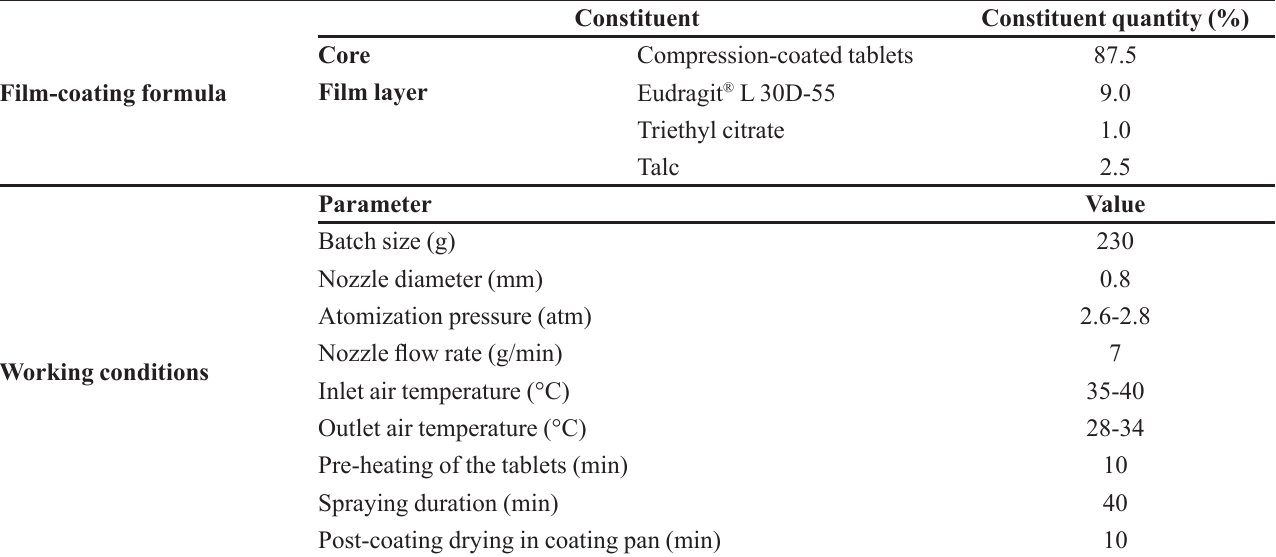
TABLE III – Film-coating formula and working conditions